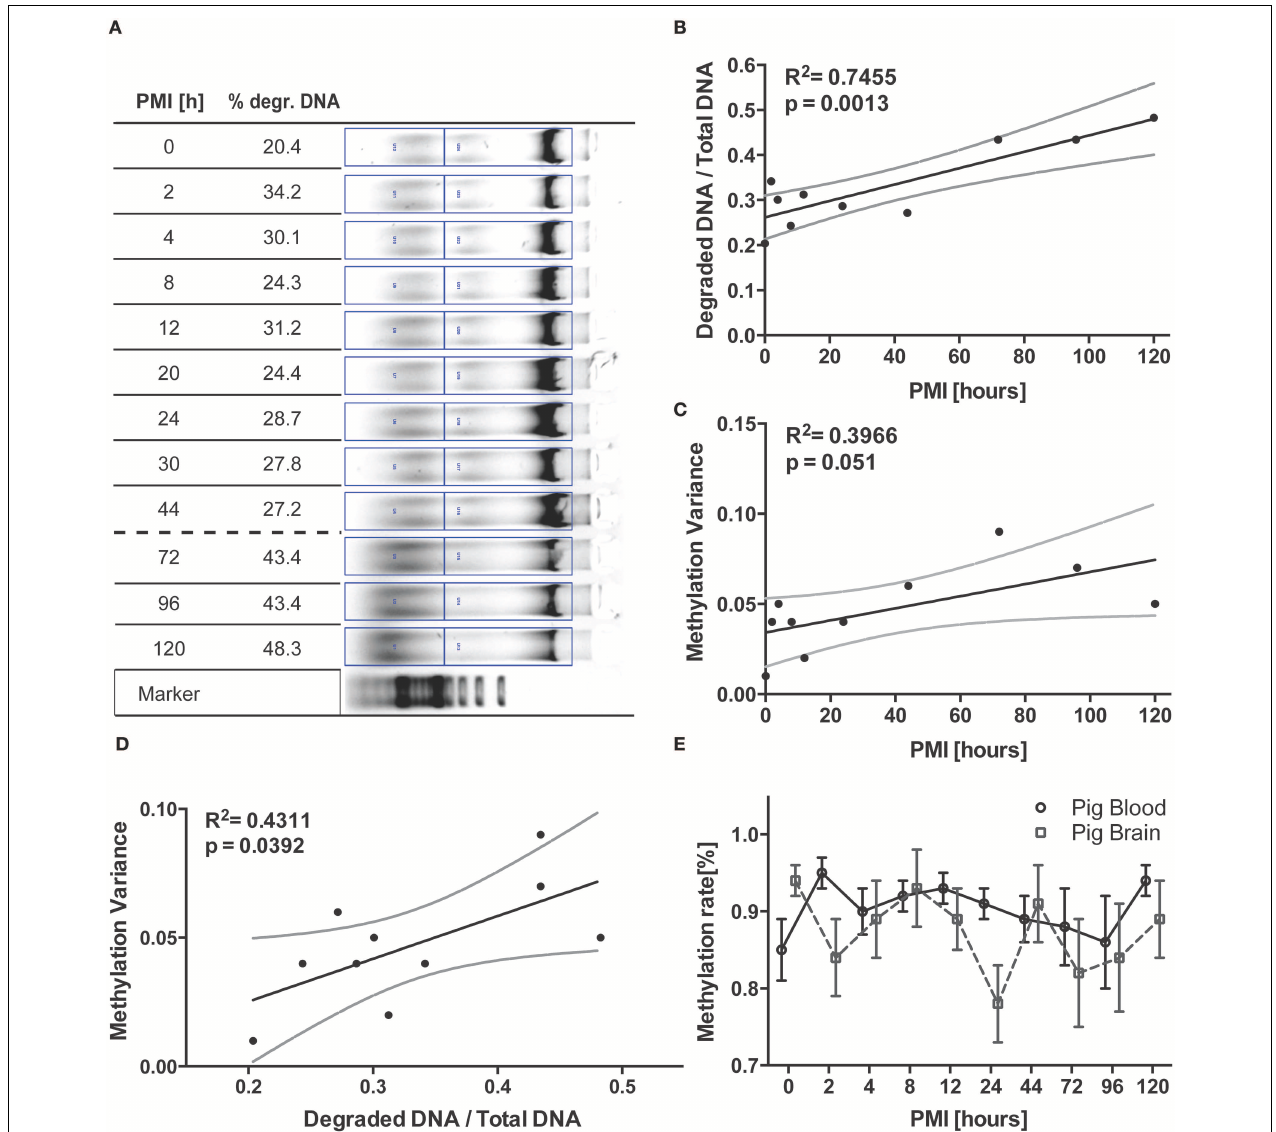
FIGURE 1 | Longitudinal pig trial. (A) DNA was isolated from pig brain tissue frozen at timepoints depicted and separated on a 0.7% agarose gel. Degraded DNA was put in relation to total DNA in the respective lane for normalization. (B) The respective graphical display of the increasing degradation ratio (degraded DNA/total DNA) and (C) likewise increasing variance of methylation data plotted against PMI were analyzed via linear regression. Variance was calculated from methylation analysis of brain